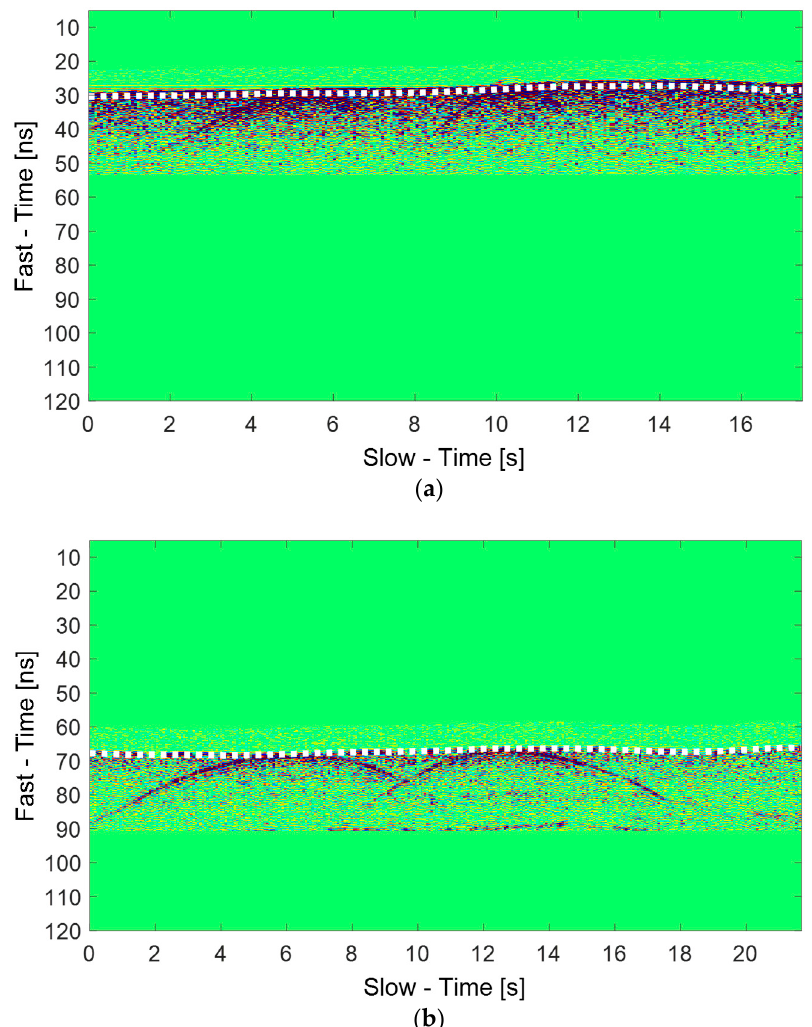
Figure 11. Filtered radargrams: ( a ) Track 1; (b) Track 2. The white dotted line represents the variable UAV flight altitude h estimated by the CDGPS and transformed in the equivalent travel time by: t h = 2 h / c 0 .